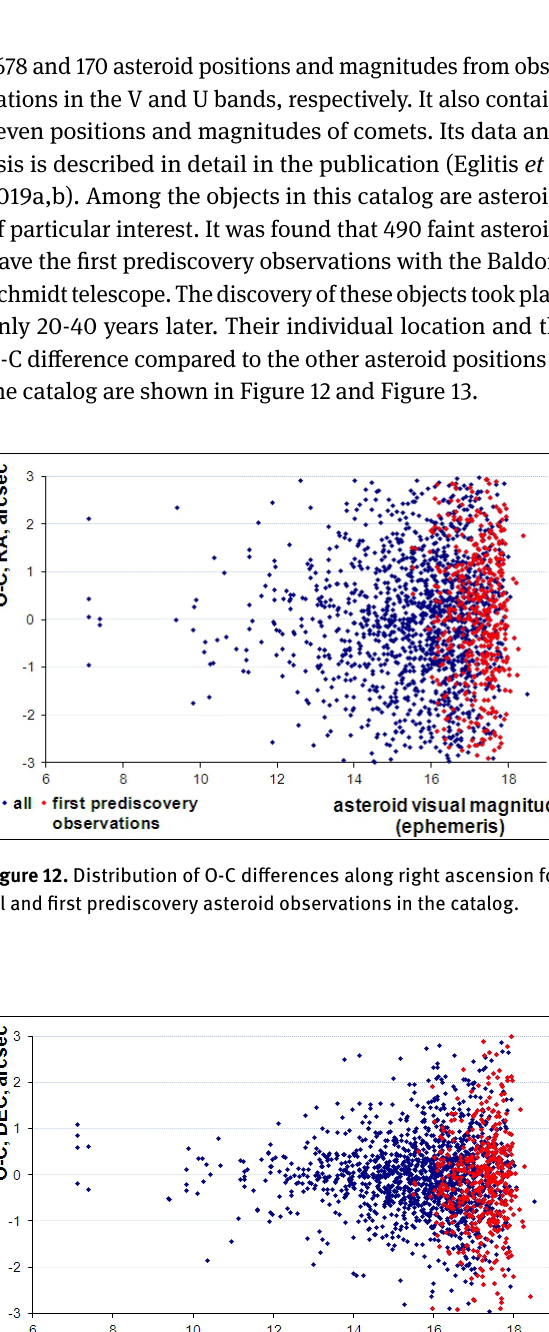
Earlier, in 2016, the first asteroid positions in the R and B color bands were obtained. The catalog of coordinates, and magnitudes for 40 asteroids is presented at the Bal- done observatory WinSCP server ftp@Schmidt.lu.lv